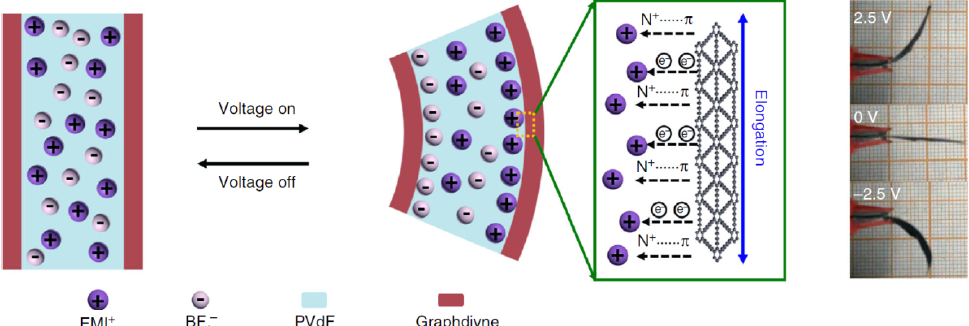
Figure 22. Schematic of the actuation mechanism in actuators with the graphdiyne electrodes. The image shows the actuator displacement at a voltage amplitude of 2.5 V and a frequency of 0.1 Hz. Reproduced from [49] with permission from Springer Nature. Copyright 2018.